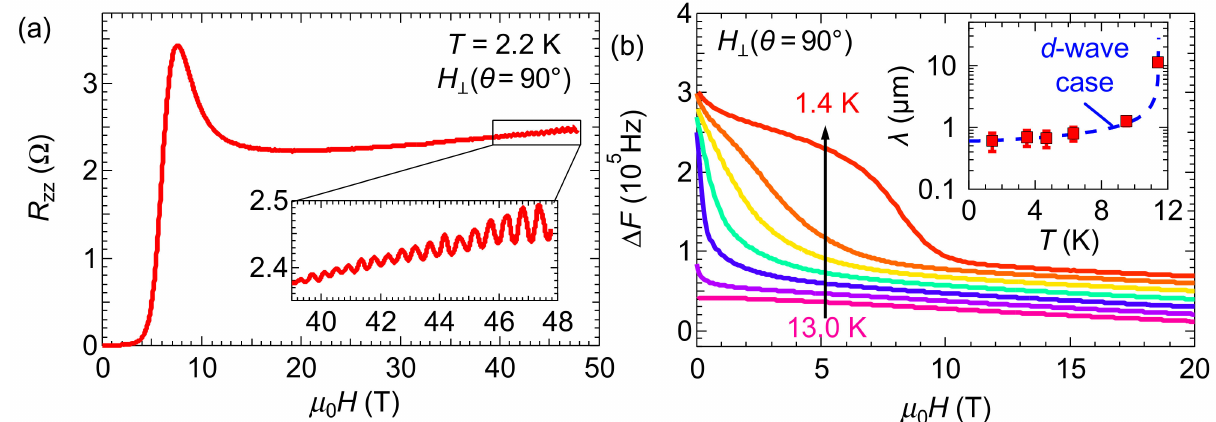
Figure 2. ( a ) Magnetoresistance at 2.2 K in a perpendicular field ( θ = 90 ◦ ). The inset is the enlarged plot above 40 T to make the quantum oscillation clearer. ( b ) Shift of the penetration depth ∆ F at various temperatures as a function of field when θ = 90 ◦ . For clarity, the datasets include offsets. The inset is the temperature dependence of the penetration depth obtained by the Equations (1) and (2). The blue dashed curve indicates behavior for simple d -wave